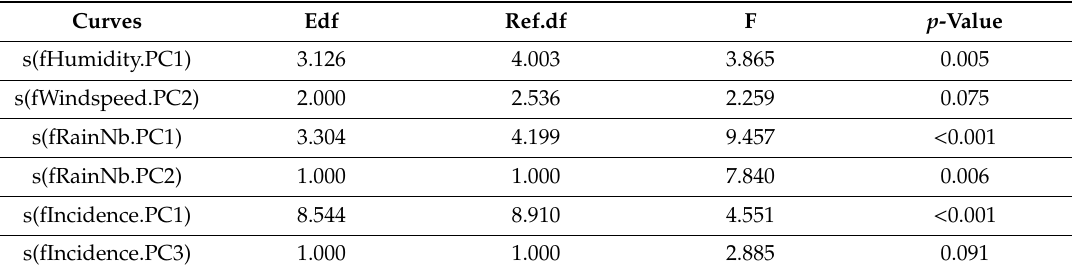
Table 3. Pertinence of partial candidate smooth functions to enter into the Functional Generalized Spectral Additive Model (FGSAM) and the nature of their relationship to the response: pertinent curves to enter in the FGSAM model f